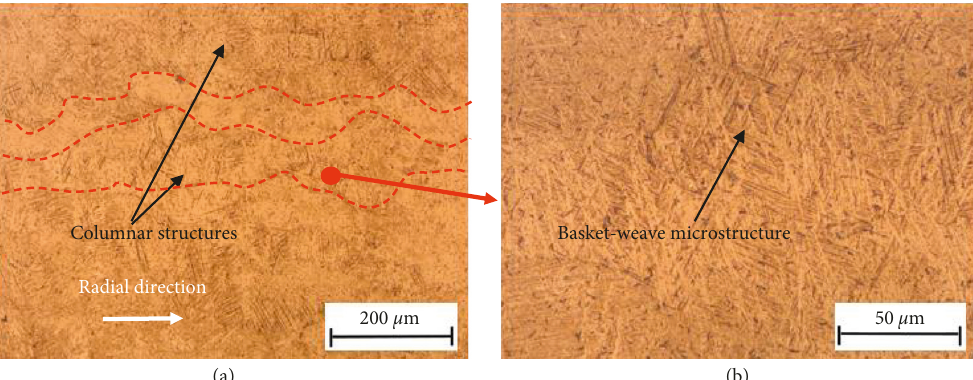
Figure 20: (a) Optical micrograph and (b) higher magnification optical micrograph, both at 25mm from the edge of the projectile hole through a 10mm thick plate.